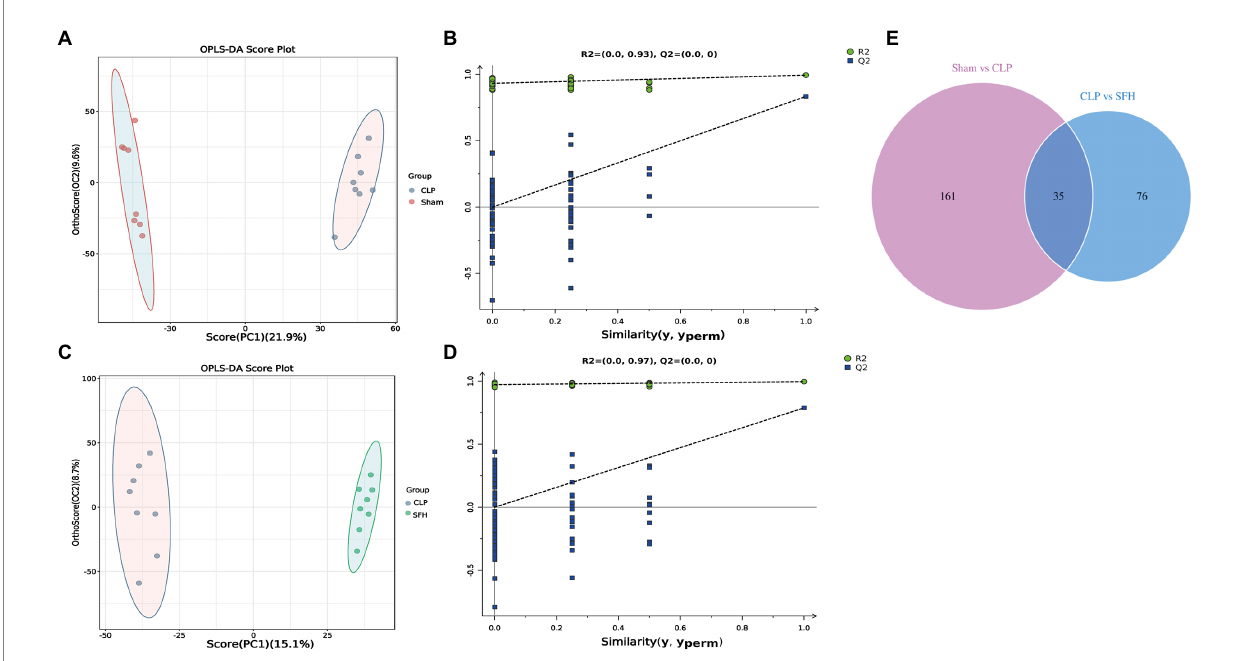
FIGURE 5 SFH treatment regulated the serum metabolites in septic mice. (A,B) Scores plots of OPLS − DA between the Sham and CLP groups and the corresponding coefficient of loading plots. (C,D) Scores plots of OPLS − DA between the CLP and SFH groups and the corresponding coefficient of loading plots. (E) Venn diagram of differential metabolites. Sham group vs. CLP group (purple) and CLP group vs. SFH group (blue) ( n = 8 per group).